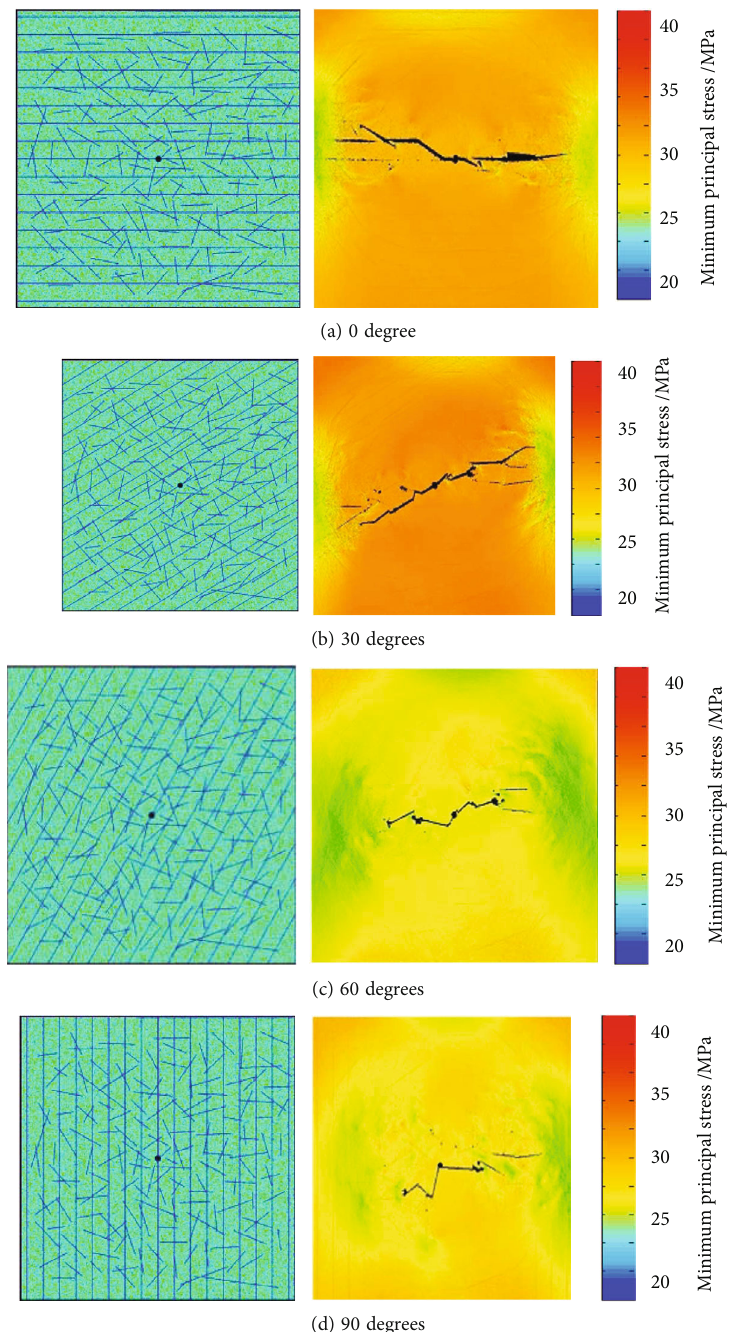
Figure 23: Fracture propagation having natural fractures and bedding plane with di ff erent angles